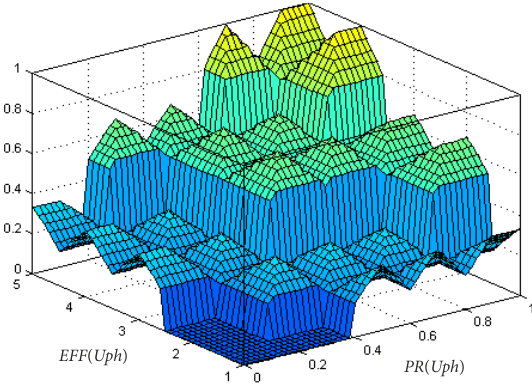
Figure 6. Surface solutions – smallest of maxima method